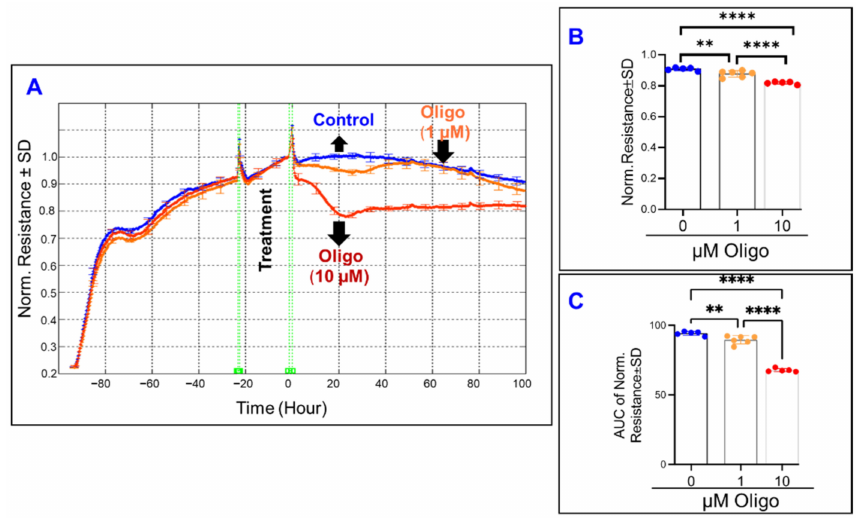
Figure 6. Real-time measurement of the total resistance across the ARPE-19 cells in a state of inhibited ATP synthase. ( A ) Plot of normalized resistance vs. time for the cell groups of the control, 1 µ M, and 10 µ M Oligomycin (Oligo). Resistance was normalized to T = 0, the time of treatment application. ( B ) Bar chart representation of each group’s normalized resistance at the endpoint of the experiment, T = 100 h. Comparison between all three groups displays a significant difference. ( C ) Bar chart representation of the areas under the normalized resistance curve for the interval T = 0–100 h. Using AUC, all three groups demonstrate a significant difference from each other. Abbreviations: Norm, normalized; AUC, area under the curve. Data shown are the mean ± SD of 5–6 independent biological replicates per group. p values are ** p ≤ 0.01 and **** p ≤